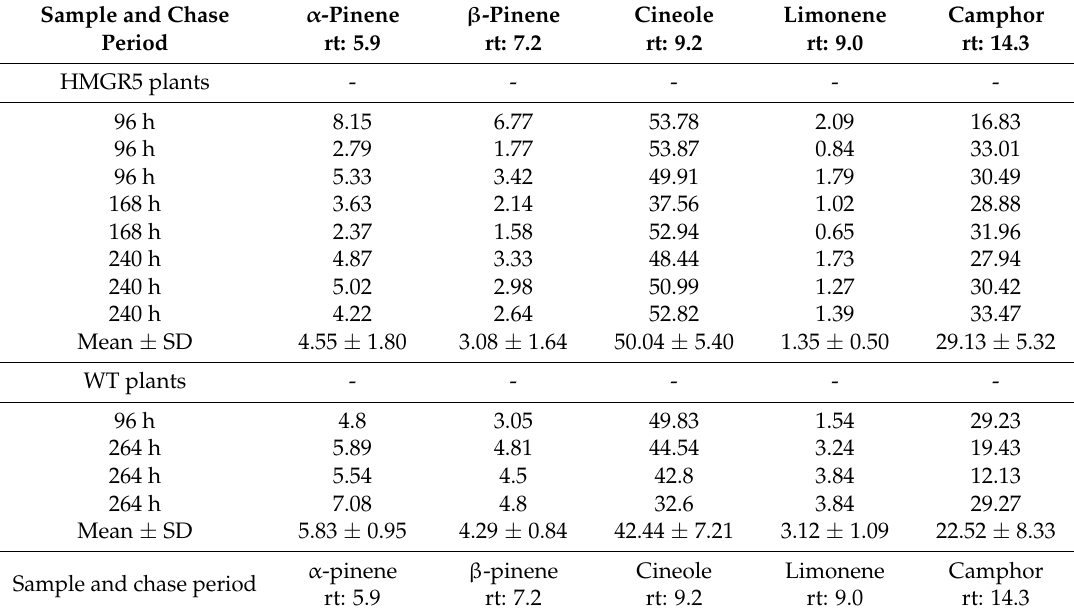
Table 5. Main components of spike lavender leaf essential oil from lines HMGR5 and WT extracted with chloroform-d and determined by GC/MS. The percentage is referred to the area of the 15 main peaks of each sample. Rt: retention time; SD: standard deviation; h: hours.